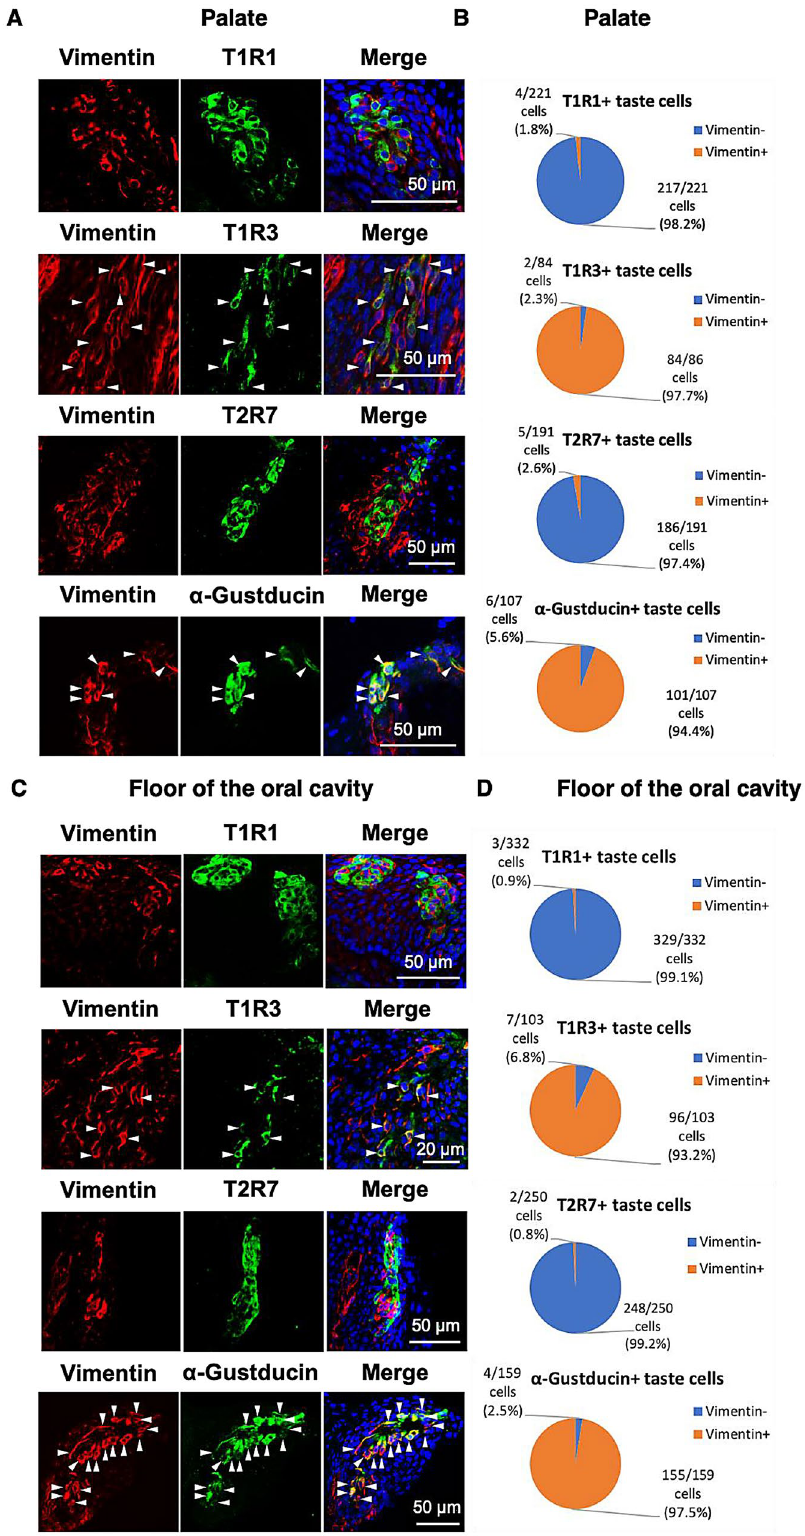
Figure 3. ( A , C ) The distributions of vimentin ( red ) and T1R1, T1R3, T2R7, or α-gustducin ( green ) immunosignals in the oral tissues in the palate ( A ) or floor of the oral cavity ( C ) of 7-day-old chickens. Arrowheads: Taste bud cells labeled by both vimentin and T1R3 or vimentin and α-gustducin. Nuclei were stained with DAPI ( blue ). The images were representative and 22 (T1R1), 32 (T1R3), 19 (T2R7), and 16 (α-gustducin) images were analyzed respectively. ( B , D ) The ratio of vimentin + cells and vimentin − cells in the T1R1 + , T1R3 + , T2R7 + , or α-gustducin + taste bud cells in the palate ( B ) and floor of the oral cavity ( D ) are